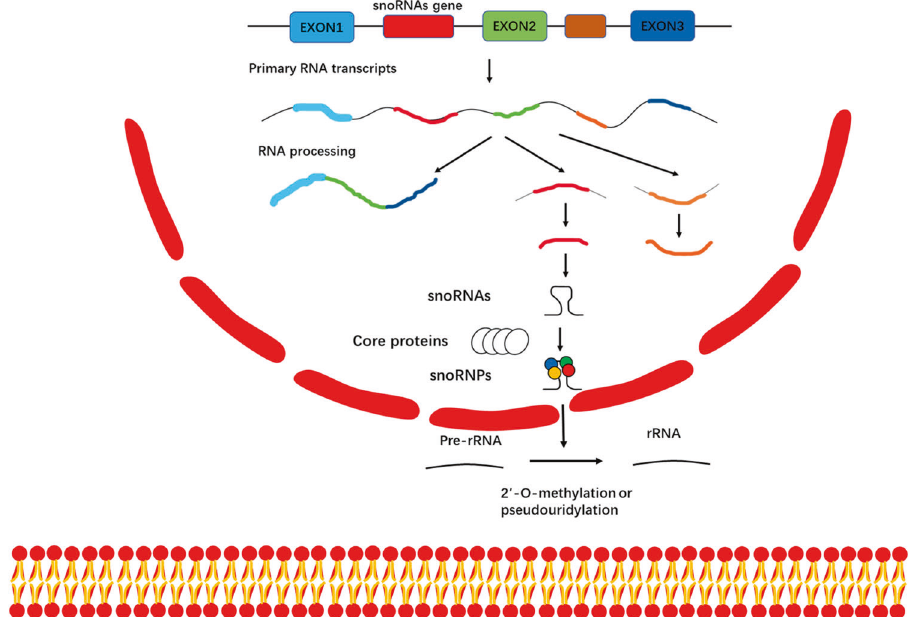
Fig. 1 The biosynthesis of snoRNAs and snoRNPs. Originate from the nucleolus, snoRNAs are mainly encoded in the intron region of the gene transcribed by RNA polymerase II. SnoRNAs form functional snoRNPs through binding to core proteins. SnoRNAs stabilize the structure of rRNA through modifying rRNA with 2 ‘ - O-methylation and